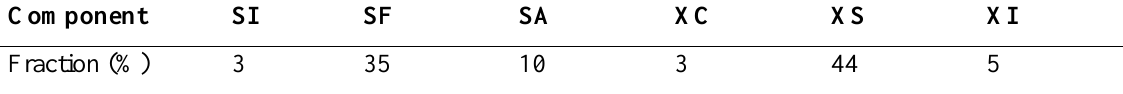
Table. 4 The fractions of COD on municipal wastewater ( Rousseau, 2006